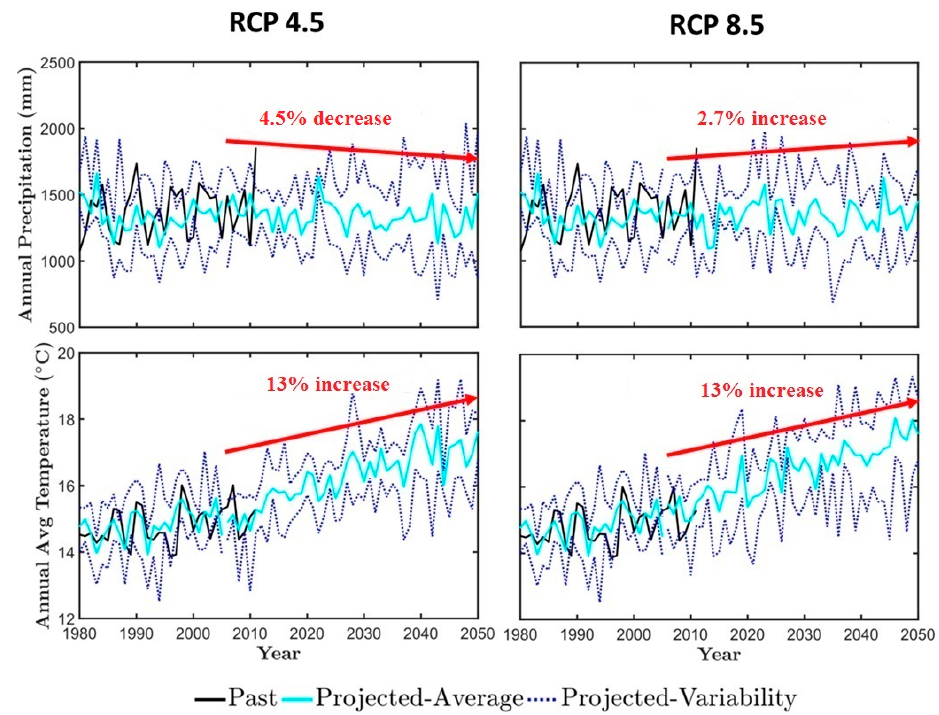
Figure 9. Annual precipitation ( top ) and temperature ( bottom ) time series based on observations for 1980–2011 and modeled climate from the fifth phase of the Coupled Model Intercomparison Project (CMIP5) [49] for historical (1980–2005) and projected (2006–2050) period according to two Representative Concentration Pathways (RCPs) [50] of RCP 4.5 ( left ) and RCP 8.5 ( right ). The average curve is the average of four GCM models, and the variability curves are the minimum and maximum of four models. The red line is the slope of the time series during the projected period. The percent change from 2006 to 2050 is shown in red above each line.